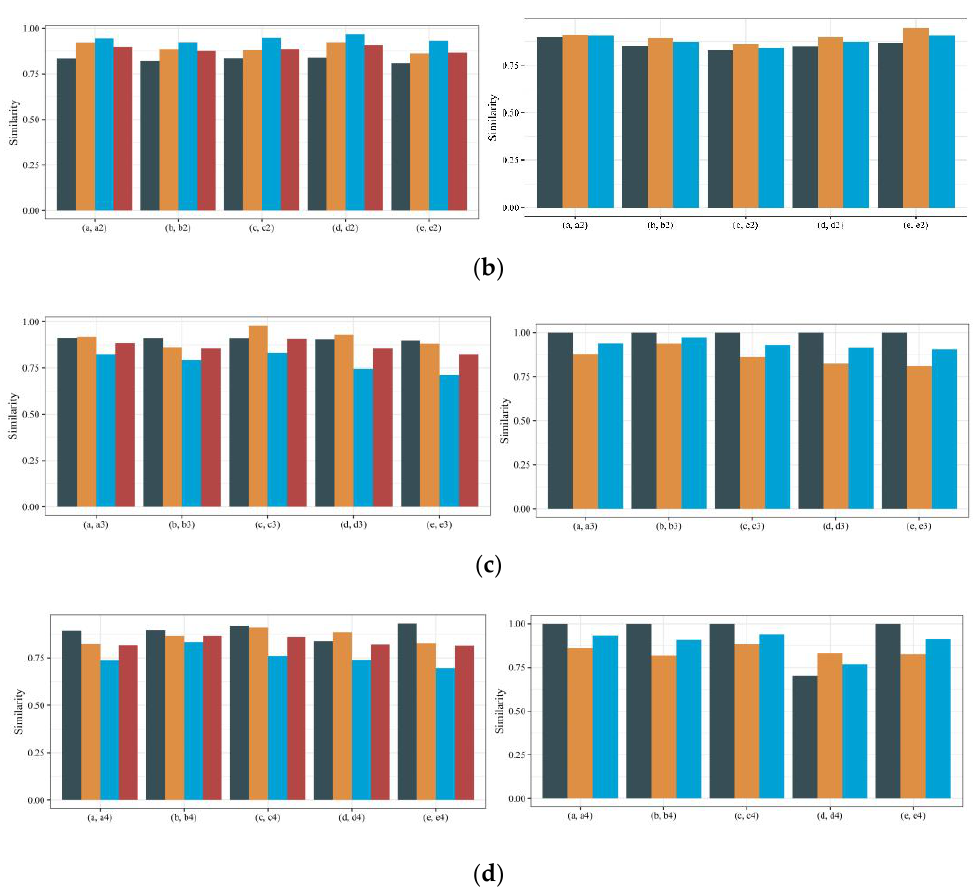
Figure 16. The similarity of the original data and generalization data calculated by the proposed method and the Fourier shape descriptor: ( a ) displacement operation; ( b ) simplify operation; ( c ) merge operation; ( d ) delete operation.